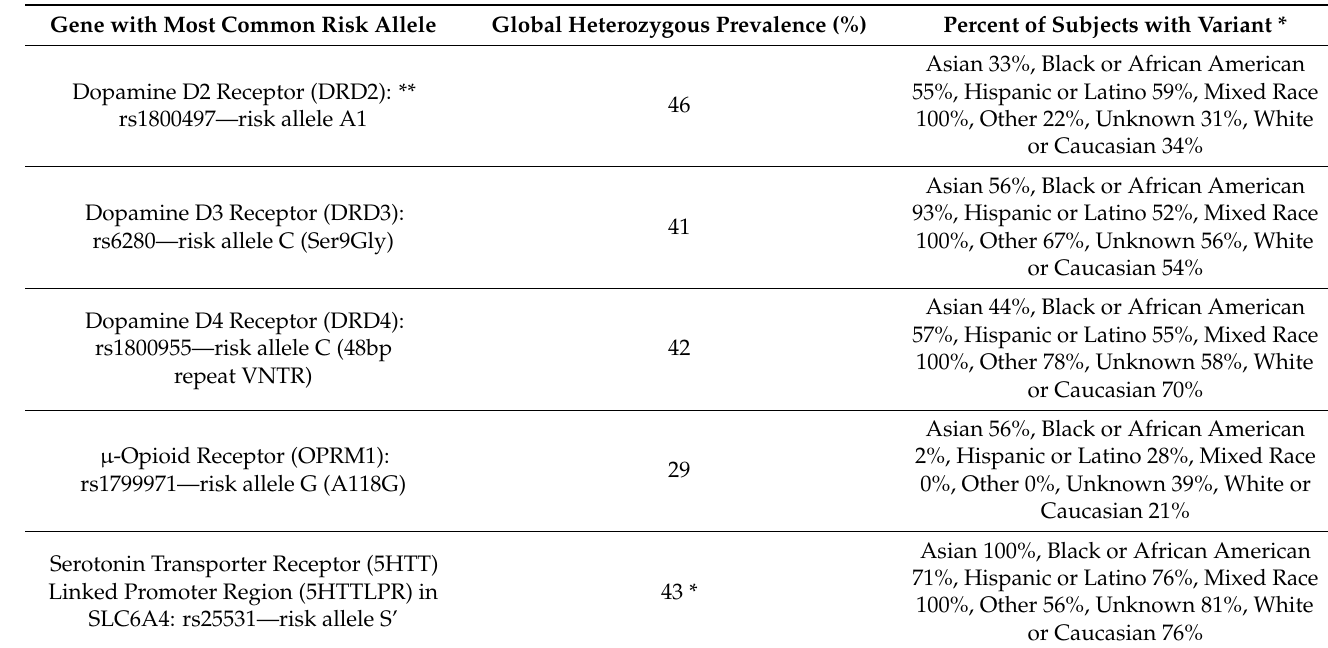
Table 1. The Global Heterozygous Prevalence of Risk Variants in the General